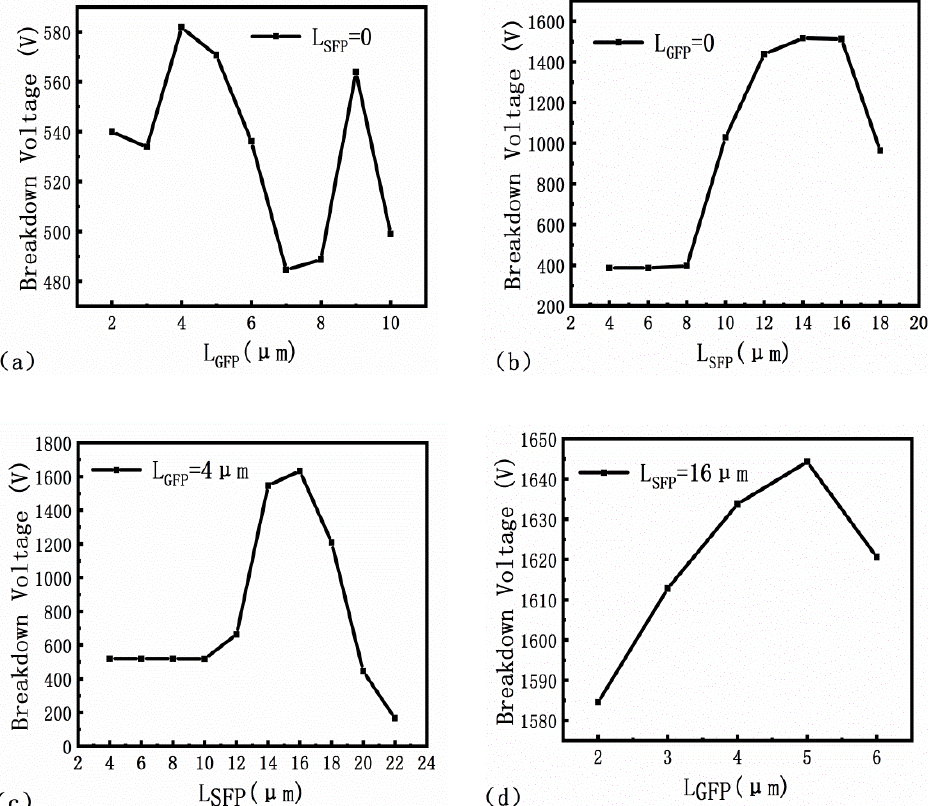
Figure 5. Variation of breakdown voltage with field plate length ( a ) single G-FP; ( b ) single S-FP; ( c ) SG-FP with L GFP = 4 μm; ( d ) SG-FP with L SFP = 16 μm.